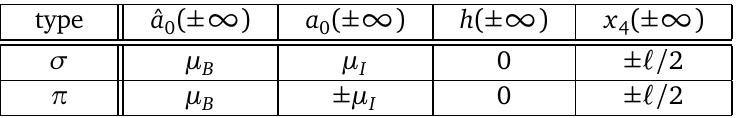
Table 2: Boundary conditions at z = ±∞ for the various components of the gauge fields and the embedding function of the flavor branes x for the deconfined geometry discussed in Sec. 4). Boundary conditions of type π ( σ ) do (do not) include pion